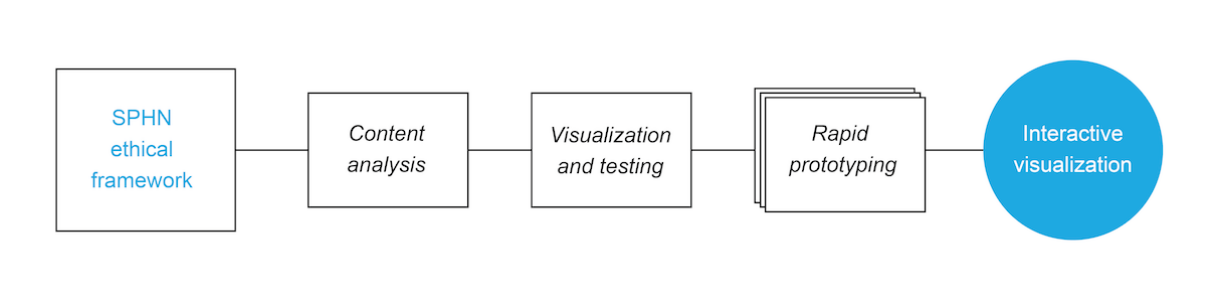
Figure 1. This figure gives an overview of the method and outlines the 3 primary steps: content analysis, visualization, and rapid prototyping. The rectangle on the left represents the Swiss Personalized Health Network’s ethical framework in its original form as a document, and the circle on the right represents the interactive visualization of the framework’s content. SPHN: Swiss Personalized Health